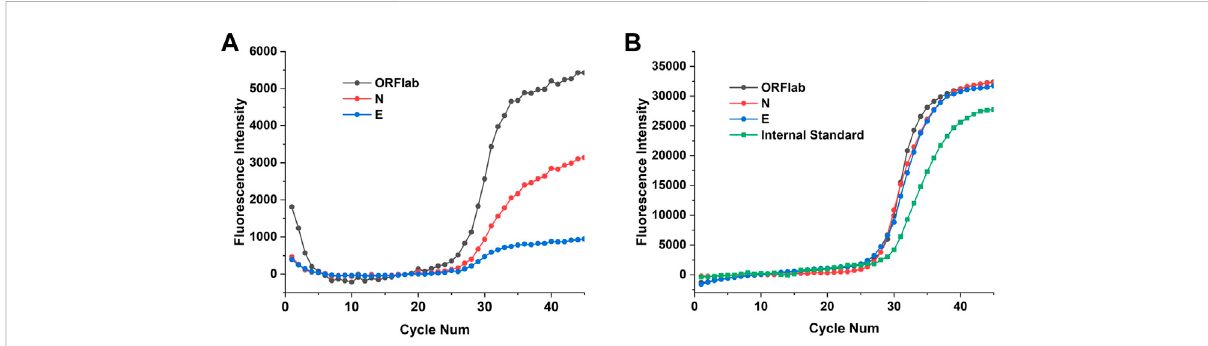
FIGURE 9 Multiplexreal-time fl uorescencePCRcurvesfor detectionofdifferenttargetsofSARS-CoV-2. (A) FluorescencecurvesofORFlabgene,Ngene andEgeneofSARS-CoV-2fromStepOnePlussystem. (B) FluorescencecurvesofORFlabgene,Ngene,Egeneandinternalstandardtargetfromthe homemade PNAD system.